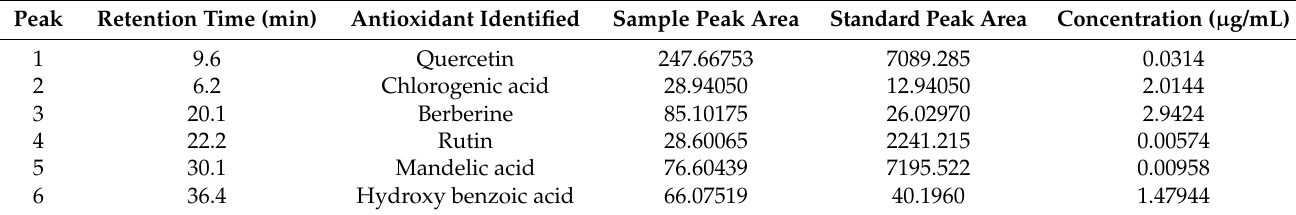
Table 4. Identified phenolic compounds in Berberis lyceum root Me. Ext.